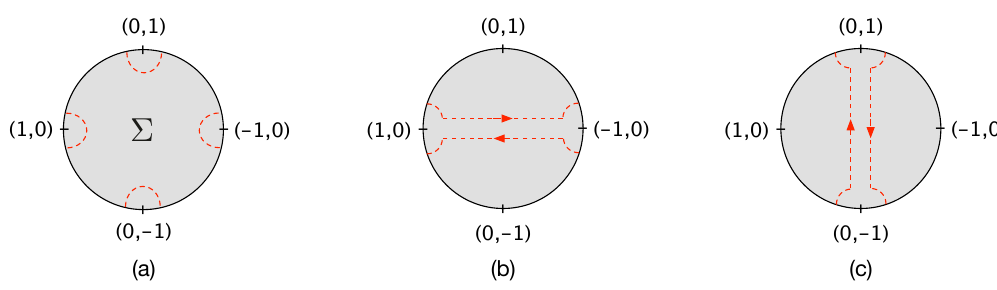
Figure 8. 3-cycles in the solution corresponding to ( cycles c , c carry nonzero (cid:13)ux. (b) The cycle c ( (cid:6) 1 ; 0) (0 ; (cid:6) 1) cycle c + c also has a vanishing (cid:13)ux, but it is equivalent to the cycle c (0 ; 1) (0 ; (cid:0) 1)